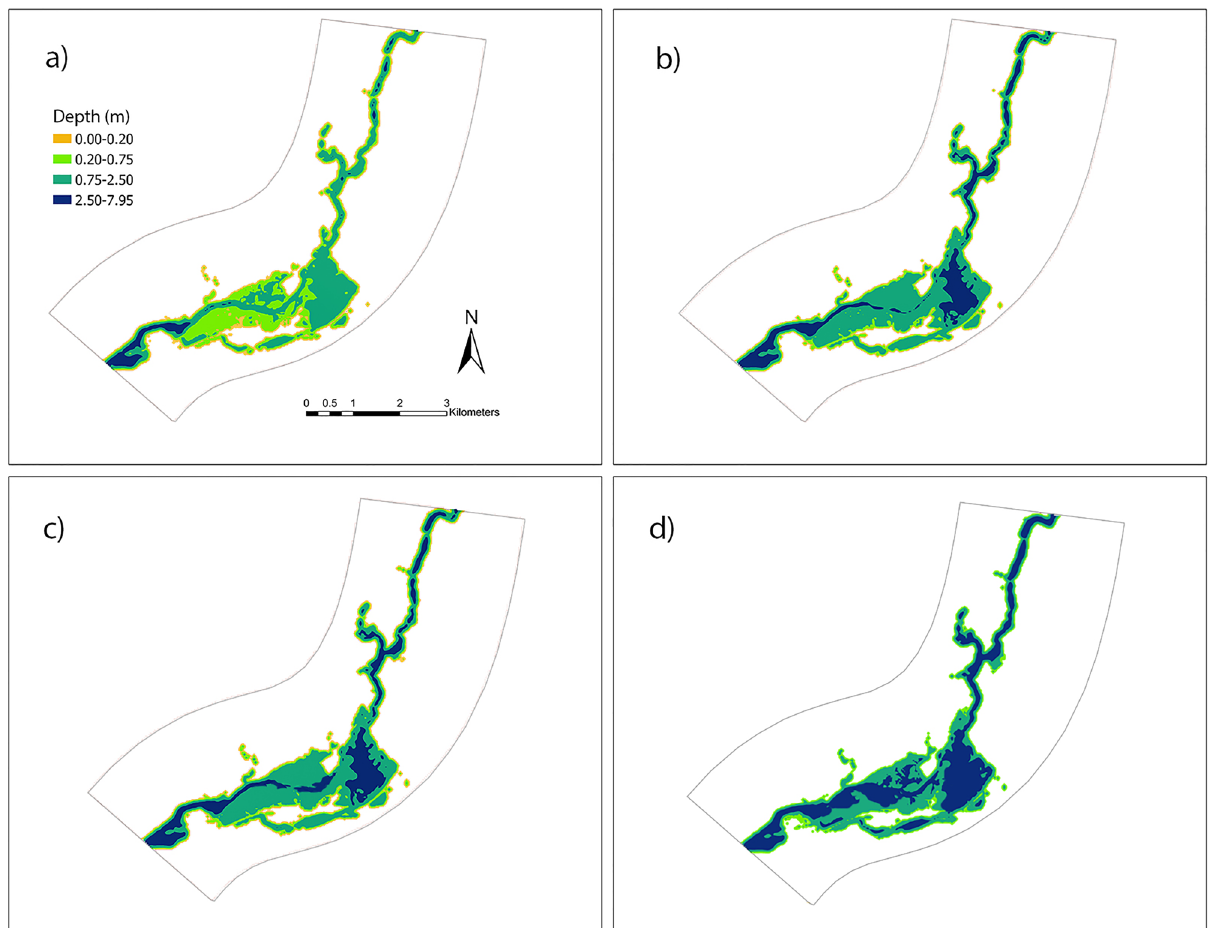
Figure 10. Predicted water depths for the representative scenarios covering the full range of upstream discharge values ( a ) 42, ( b ) 52, ( c ) 99 and ( d ) 164 cms outputs from the DNN regression model. Maps are processed and generated in the ArcGIS Pro platform 81